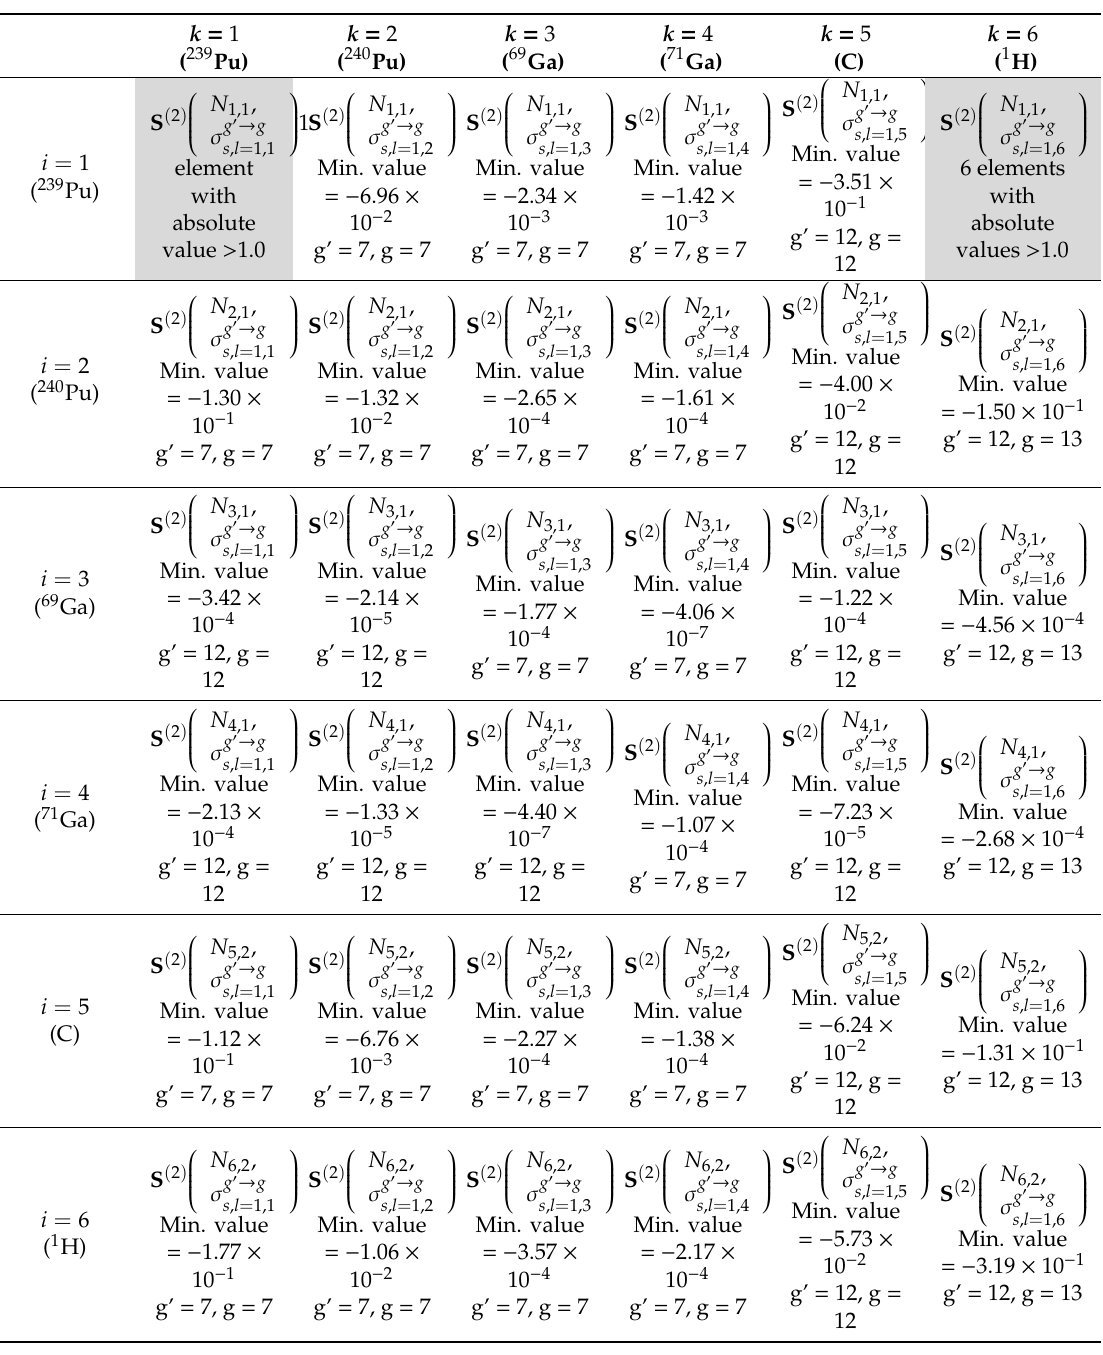
Table 15. Summary presentation of the matrix S ( 2 ) sensitivities of the leakage response with respect to the isotopic number densities and the 1st-order ( l = 1 ) scattering cross sections for all